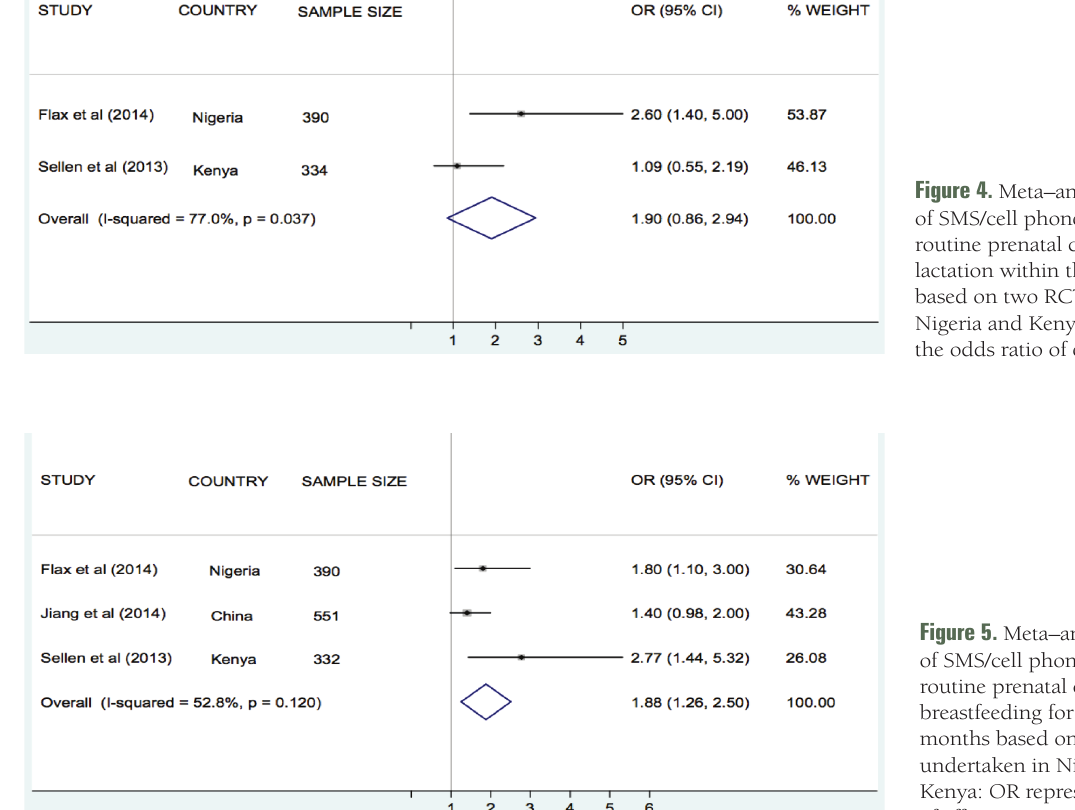
Figure 5. Meta–analysis of the effect of SMS/cell phone intervention vs routine prenatal care on exclusive breastfeeding for three or four months based on three RCT undertaken in Nigeria, China, and Kenya: OR represents the odds ratio of effect.